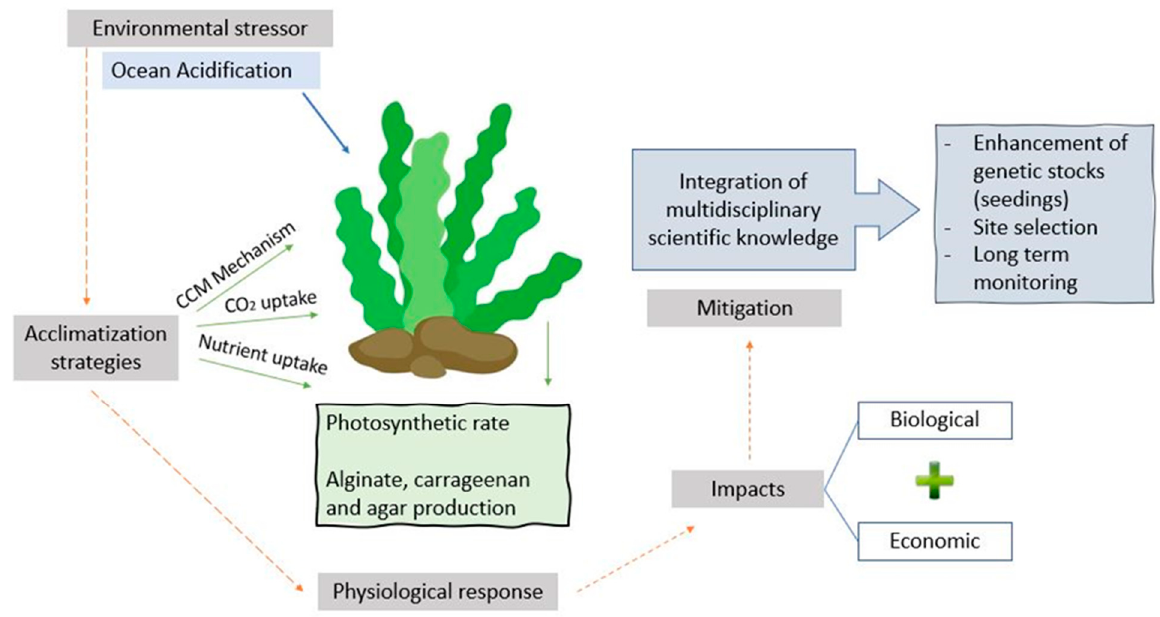
Figure 2. Radar chart that illustrates the existing knowledge gaps in relation to the main thematic areas for mitigating the effects of OA on seaweed aquaculture.